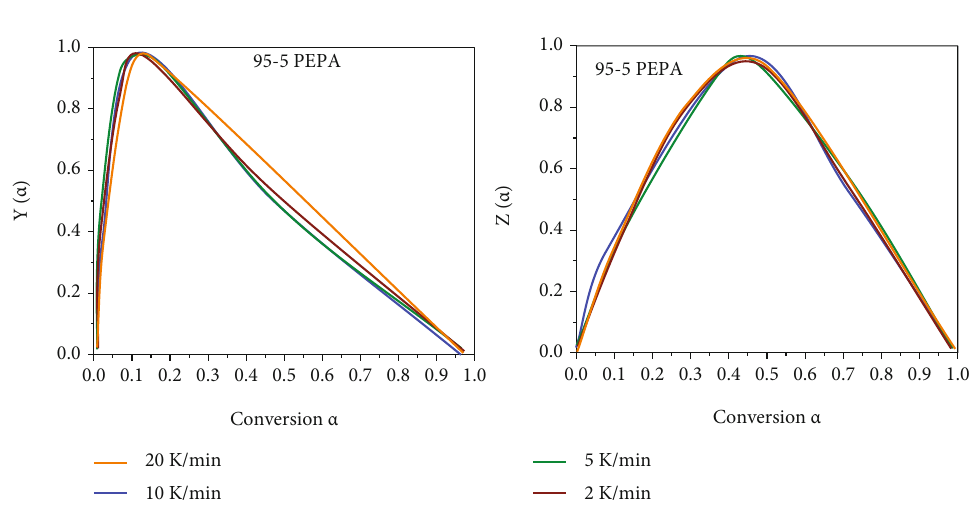
Figure 7: Functions of y ð α Þ and z ð α Þ vs. conversion